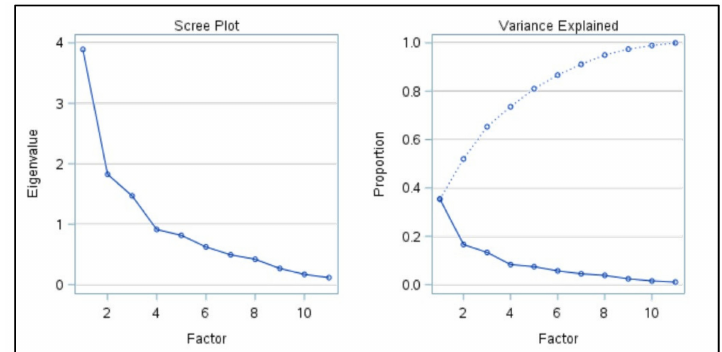
Figure 8. Eigenvalues and proportion from the PCA